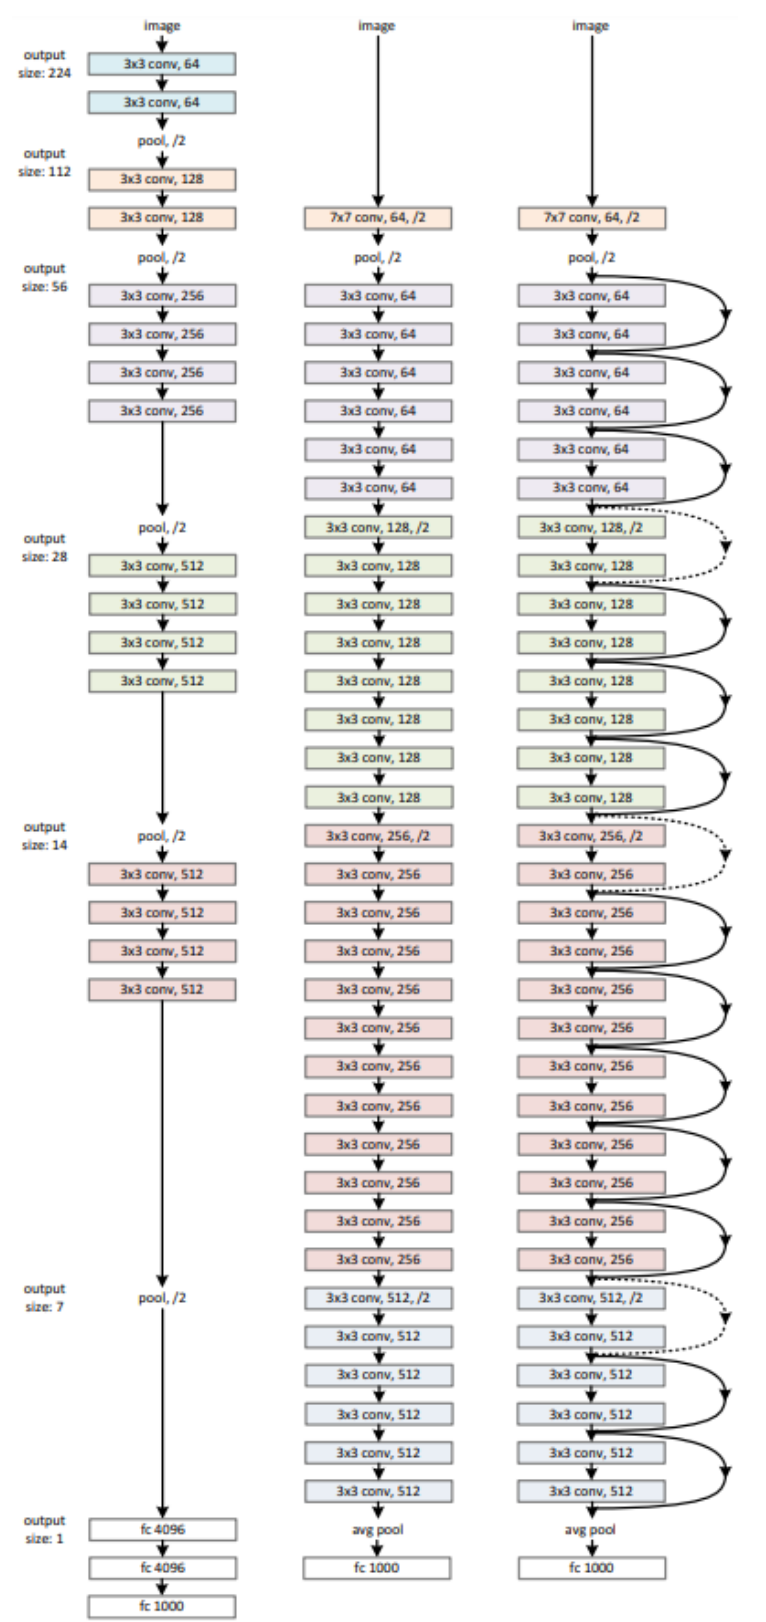
Figure A2. Example network architectures for ImageNet. Left: the VGG-19 model. Middle: a plain network with 34 parameter layers. Right: a residual network with 34 parameter layers. The dotted shortcuts increase dimensions. Source: [15], used with